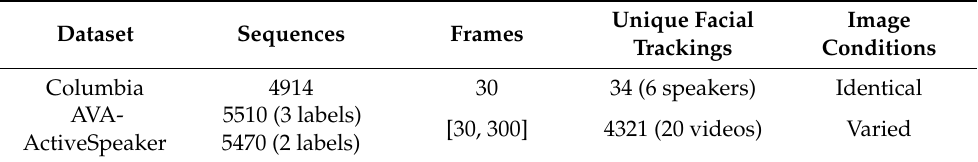
Table 1. Overview of the data used in the experiments. The Unique Facial Trackings factor is provided in place of number of speakers considering that AVA-ActiveSpeaker does not inform on speaker amount. Same person has been manually verified to not exist in two different videos.